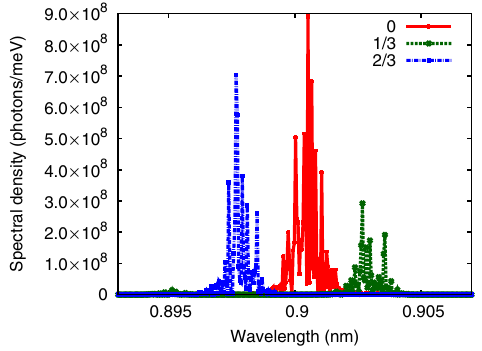
FIG. 1. Spectrum at the fundamental resulting from fixed phase shifters with shifts of 0, 1 = 3 , and 2 = 3 of a cycle, normalized for a pulse duration of 50 fs.